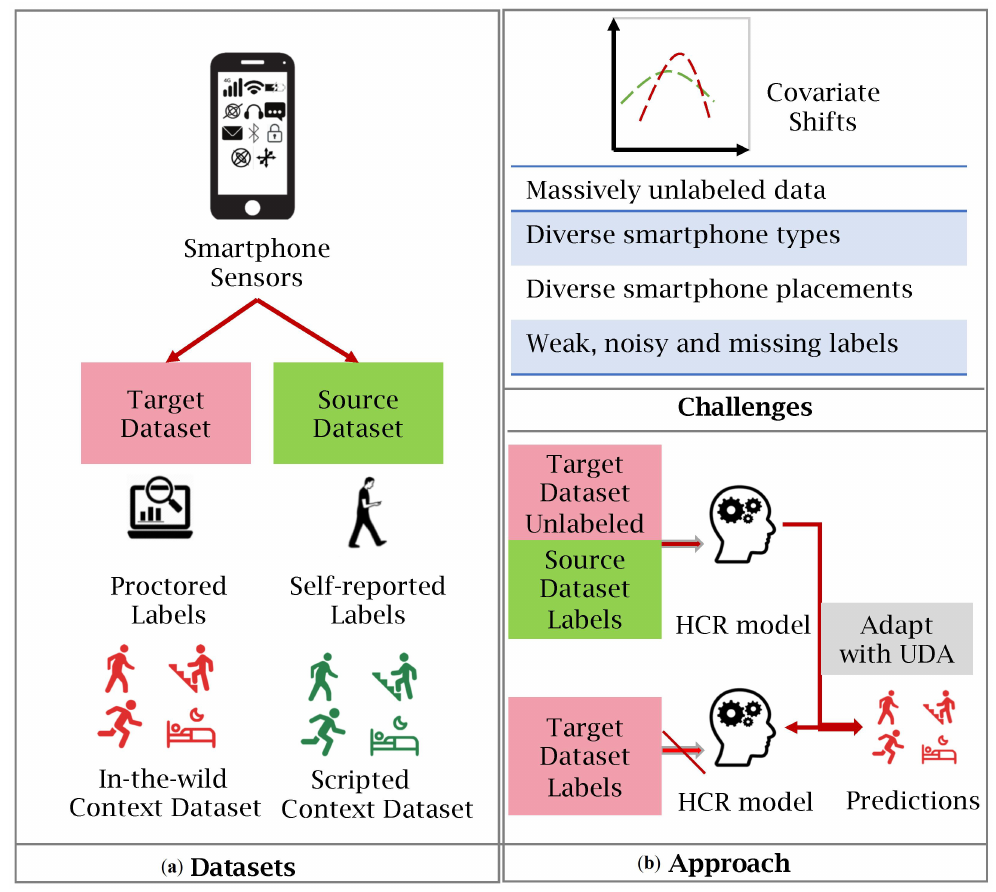
Figure 2. ( a ) The two kinds of smartphone context data used in this work. ( b ) Overview of Triple- DARE ’s problem and